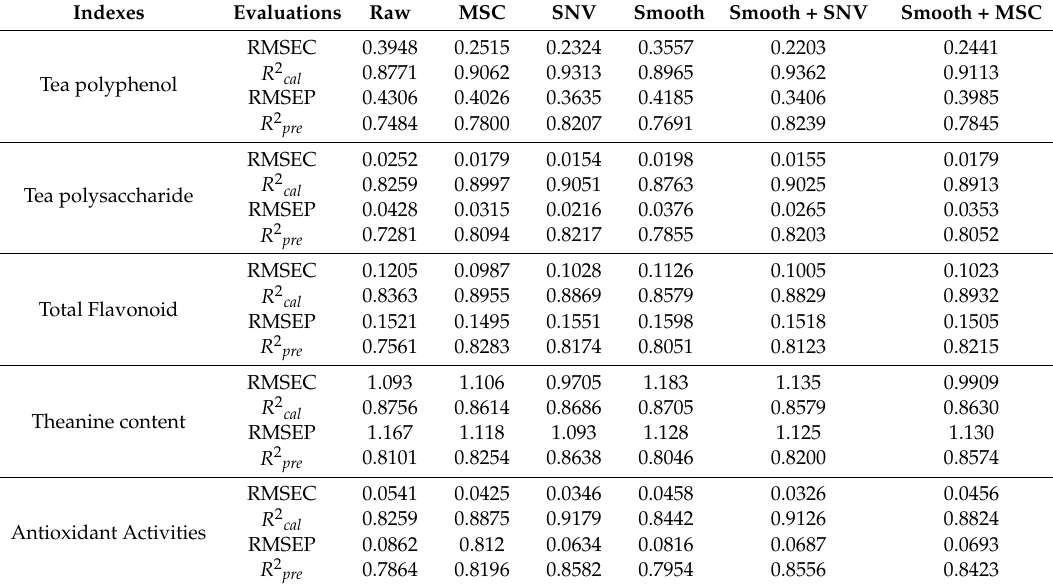
Table 2. Results for calibration model with different spectrum pre-processing based on Raw PLS algorithm.